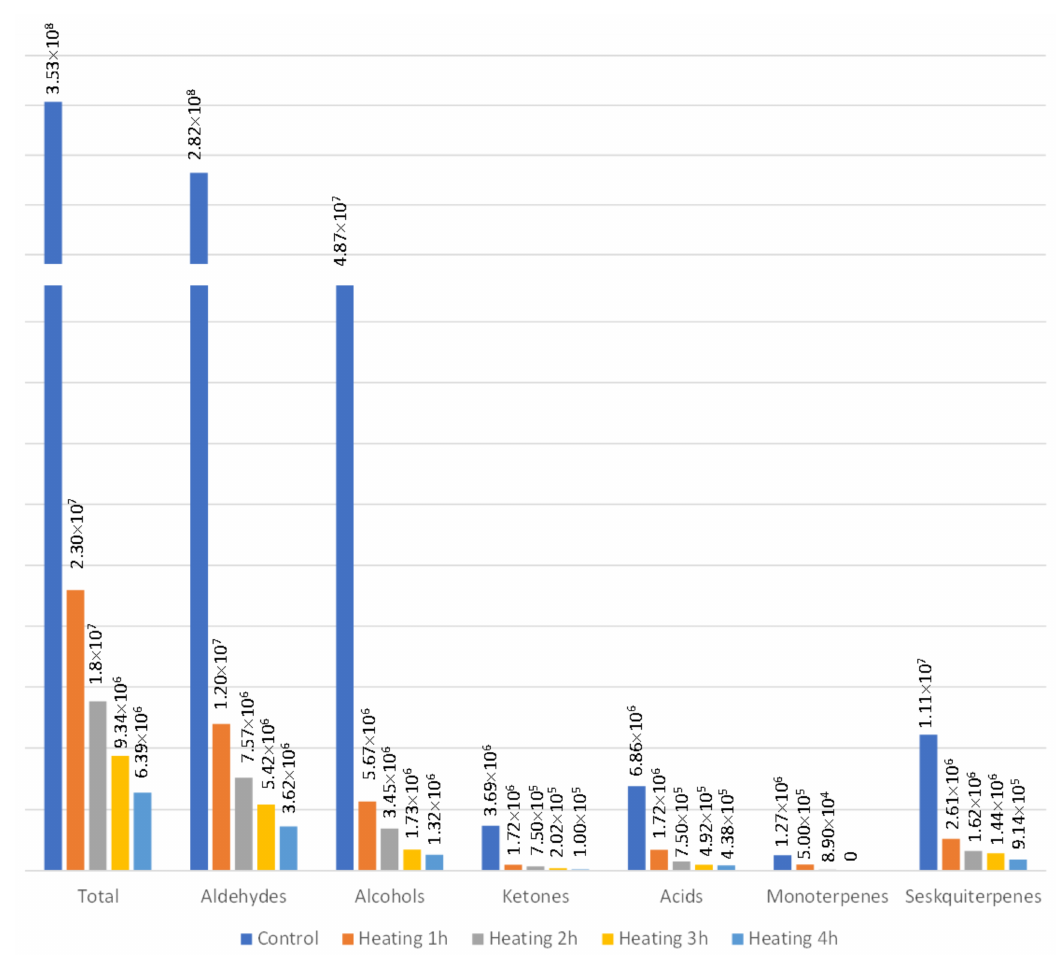
Figure 4. The effect of different heating times on different classes of free volatiles represented as absolute peak